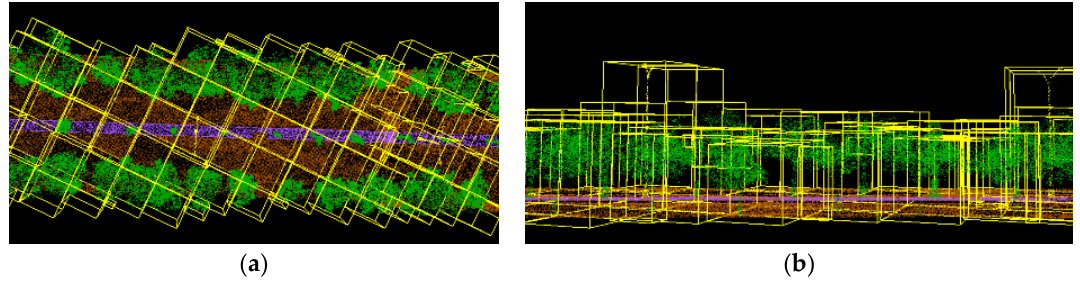
Figure 7. Construction of non-overlapping blocks measuring 5 m × 5 m for MLS point clouds: ( a ) Top view: ( b ) Side view.